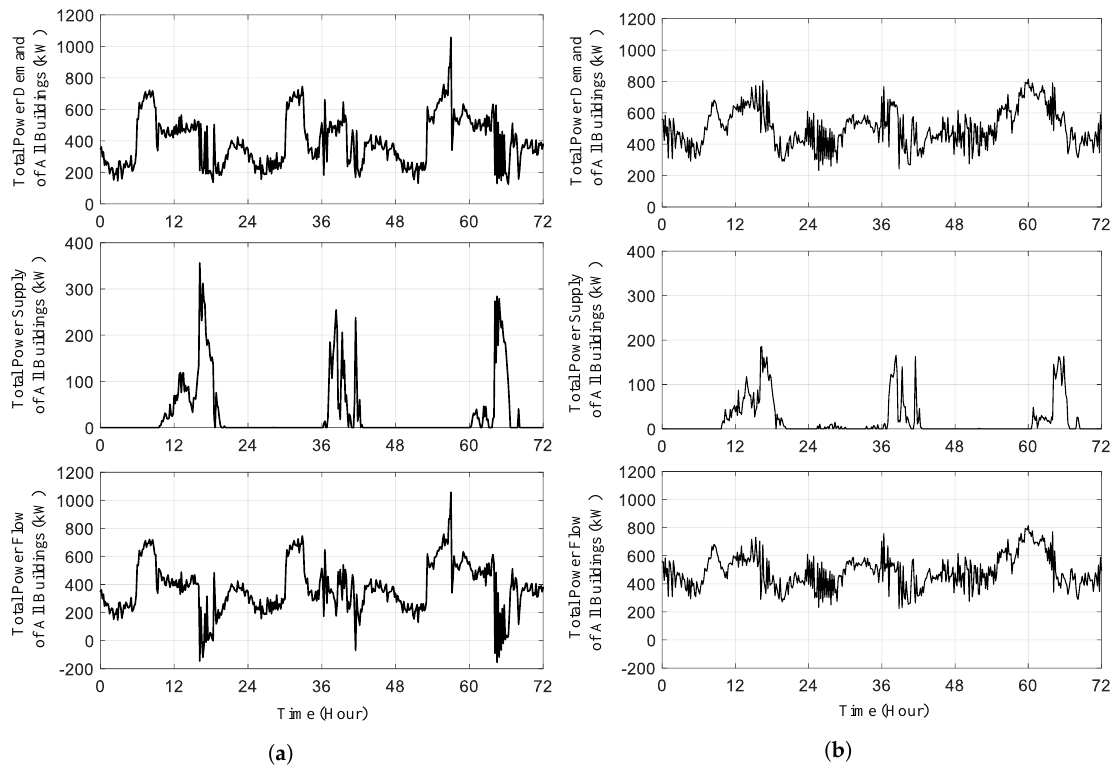
Figure 6. Overall power flow profiles of all buildings: ( a ) without dissipativity based coordination; ( b ) with dissipativity based